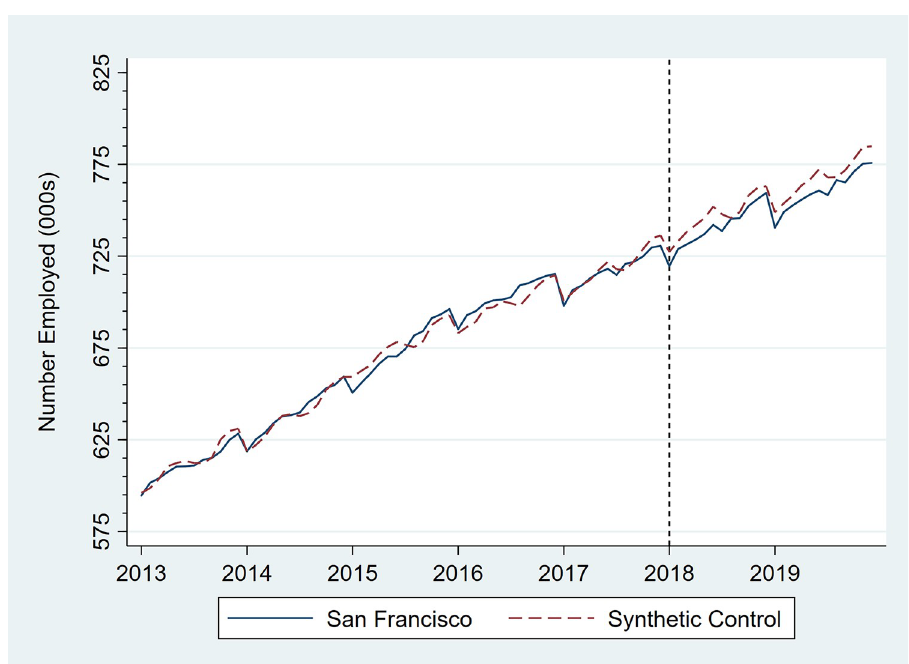
Fig 1. Total number of persons employed, San Francisco, CA, and its synthetic control, monthly, January 2013 through December 2019.